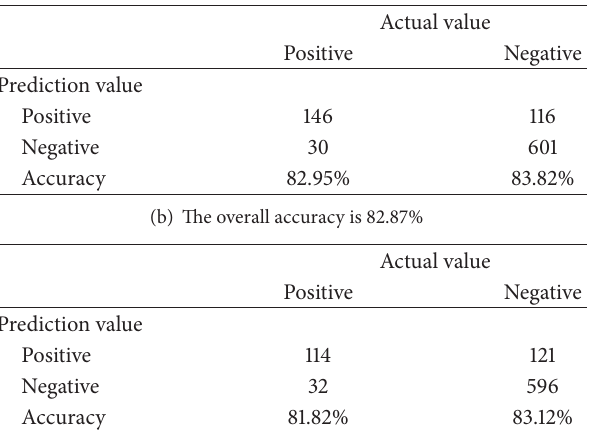
Table 1: Confusion matrix for the prediction results with (a) and without (b)